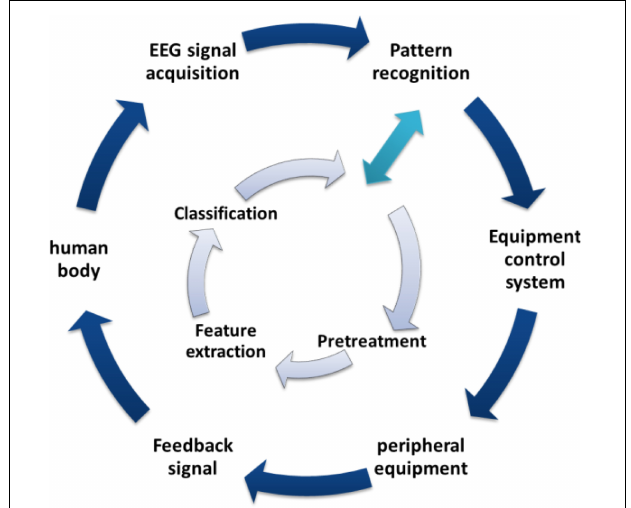
FIGURE 1 | MI-BCI system